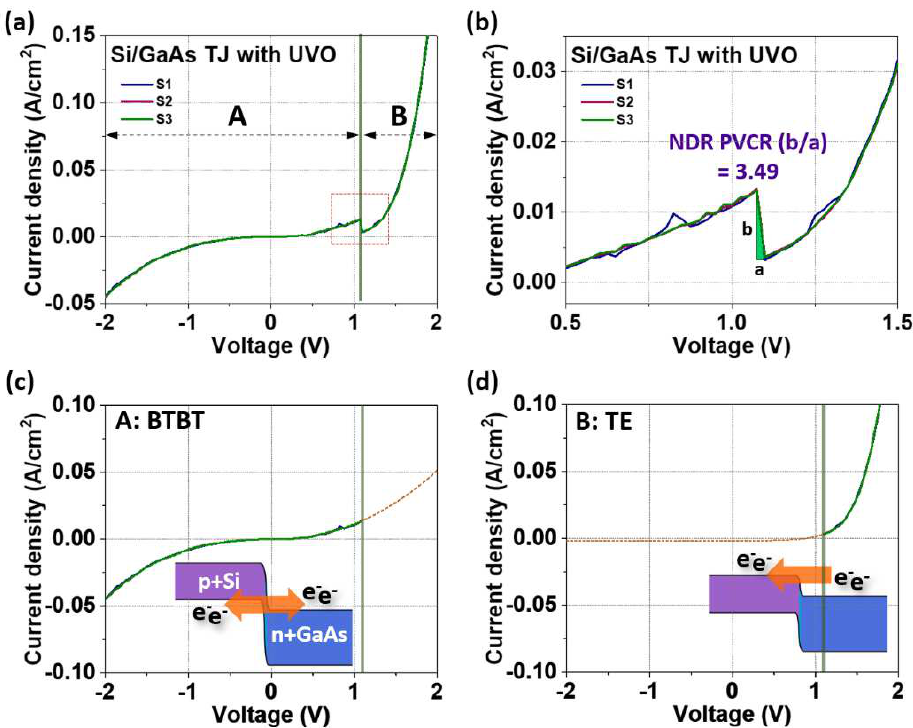
Figure 2. Electrical properties of the UVO-treated Si/GaAs heterojunctions at room temperature. ( a ) I–V curves of the UVO-treated Si/GaAs TJs. The curve is divided into A: band-to-band tunneling (BTBT) and B: thermionic emission (TE) regions. S1, S2, and S3 denote sample 1, sample 2 and sample 3. ( b ) Enlarged region for negative differential resistances with an average peak-to-valley current ratio of 3.49. Curve fitting (red dashed lines) for ( c ) A: BTBT and ( d ) B: TE. The insets in ( c , d ) represent the injection of charge carriers in the energy band diagram of the UVO-treated p+Si/n+GaAs TJs under different biases,